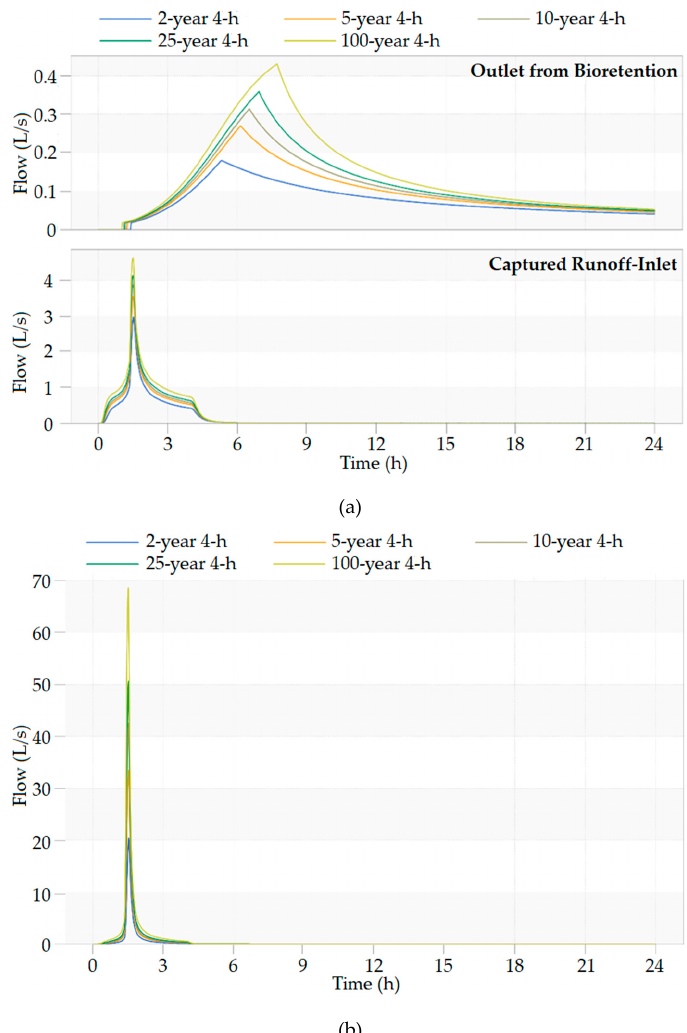
Figure 11. Hydrographs of a single and twin honeycomb catch basin; ( a ) inlet and outlet hydrographs; and ( b ) bypassed hydrographs. Table 7. Runoff control performances of single and twin honeycomb catch basin.